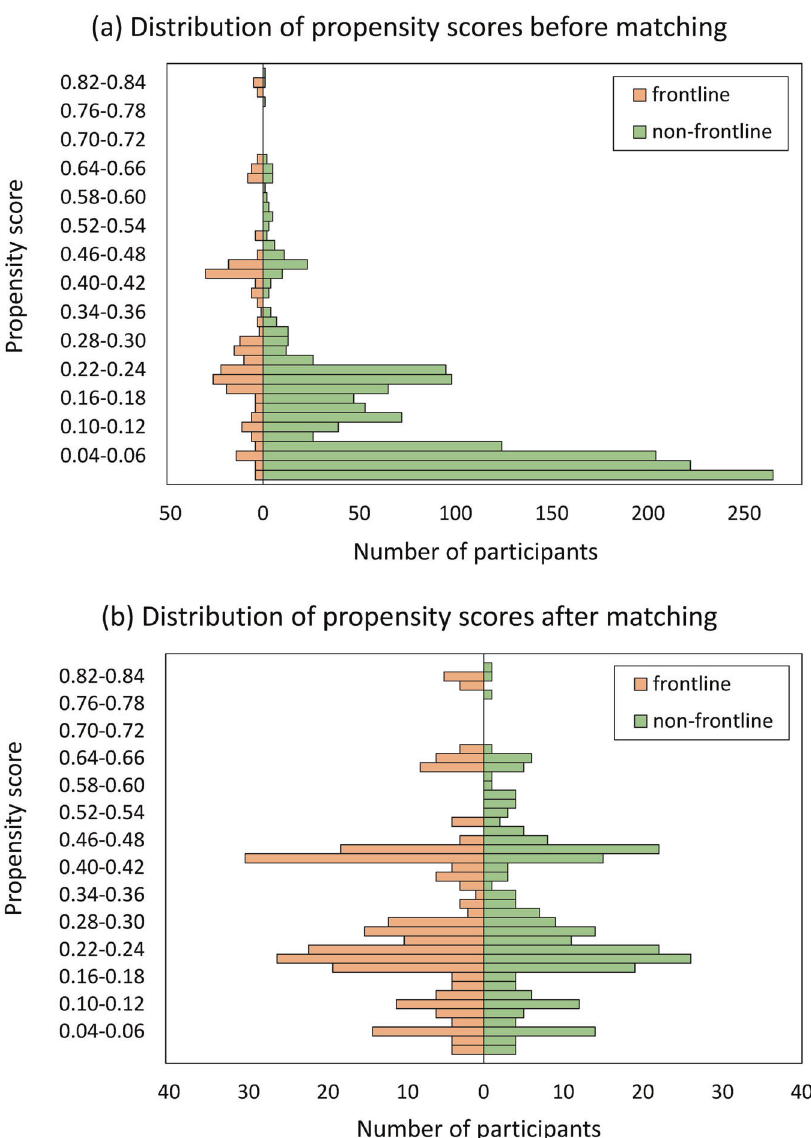
Fig. 1 Distribution of propensity scores before and after